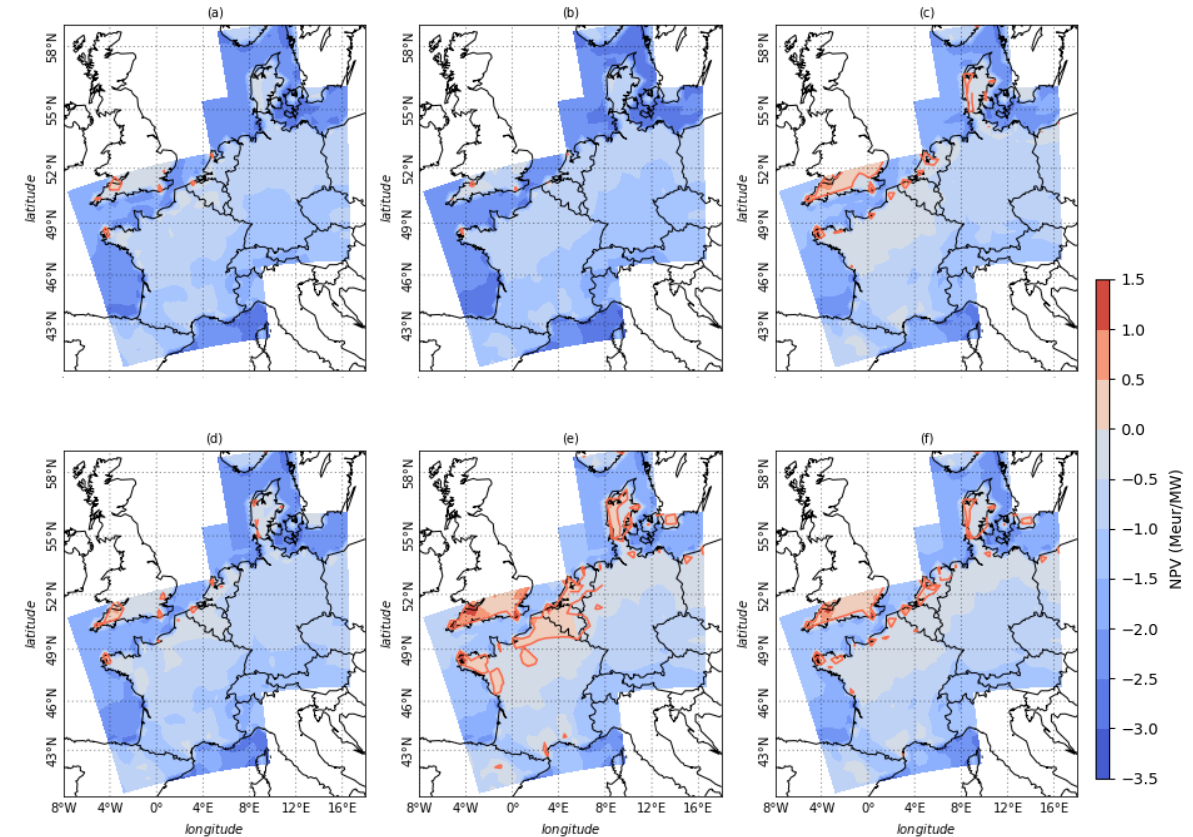
Figure 9. Net present value, averaged over the 10 CORDEX simulations (5 models and 2 RCPs), for the 6 prices scenarios. The red line shows the boundary between regions with positive and negative NPV. Scenario 1: No demand trends and low wind penetration ( a ); Scenario 2: No demand trends and high wind penetration ( b ); Scenario 3: Medium demand trends and low wind penetration ( c ); Scenario 4: Medium demand trends and high wind penetration ( d ); Scenario 5: High demand trends and low wind penetration ( e ); and Scenario 6: High demand trends and high wind penetration ( f